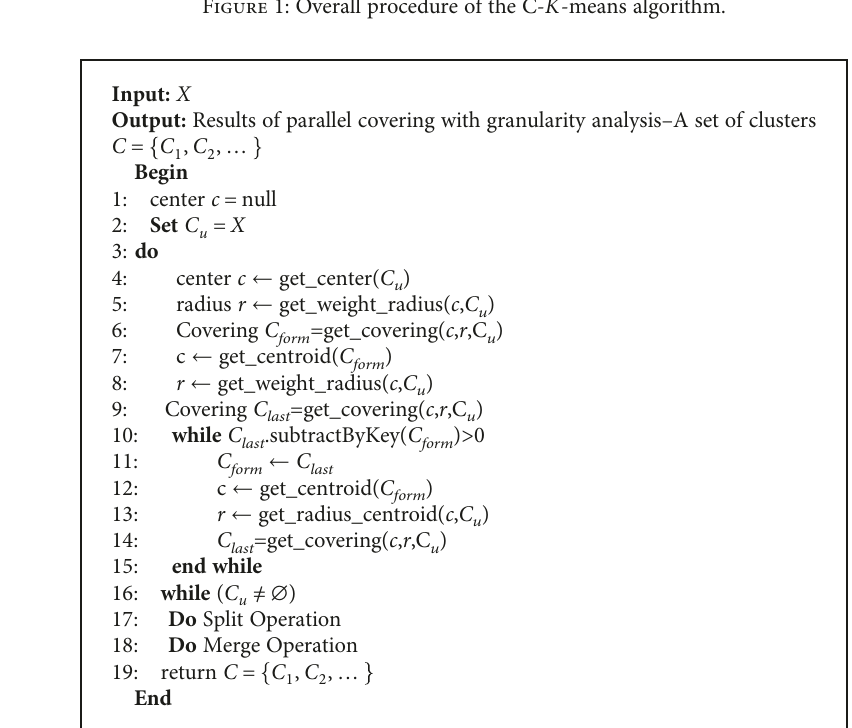
Figure 1: Overall procedure of the C- K -means